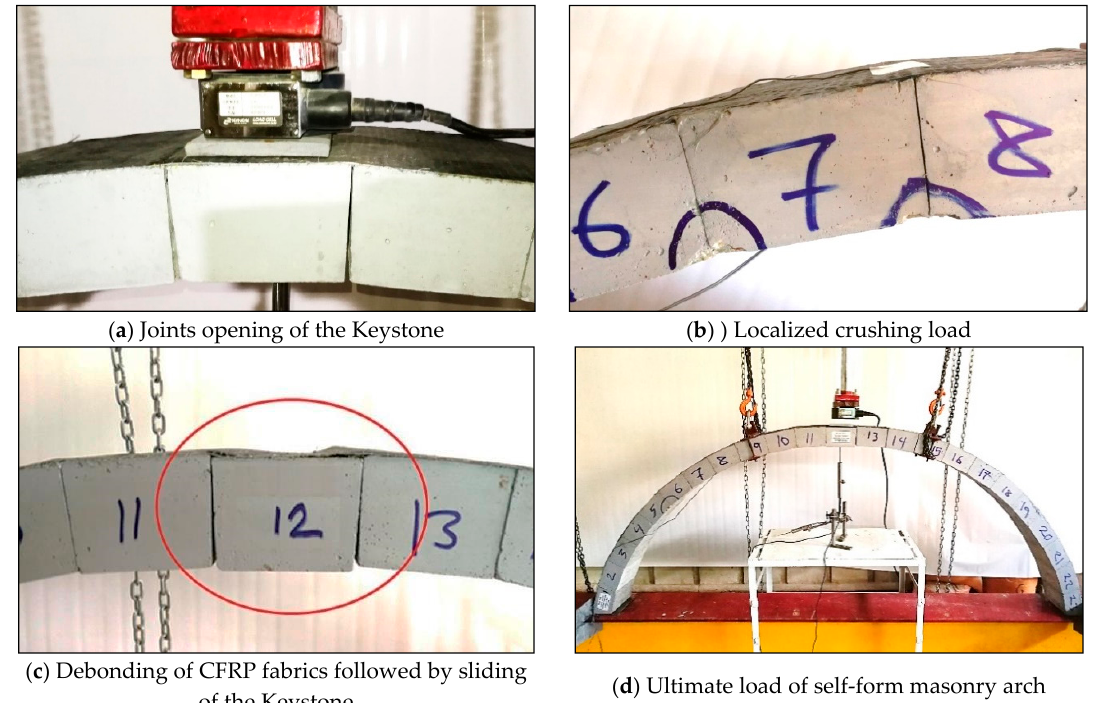
Figure 11. Loading stages of self-form segmental concrete masonry arches.